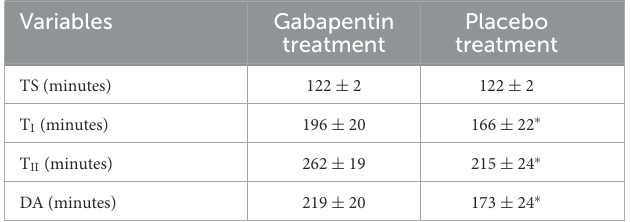
TABLE 2 Time from gabapentin/placebo administration to starting MAC determination, the first and second MAC determination. Variables Gabapentin Placebo treatment